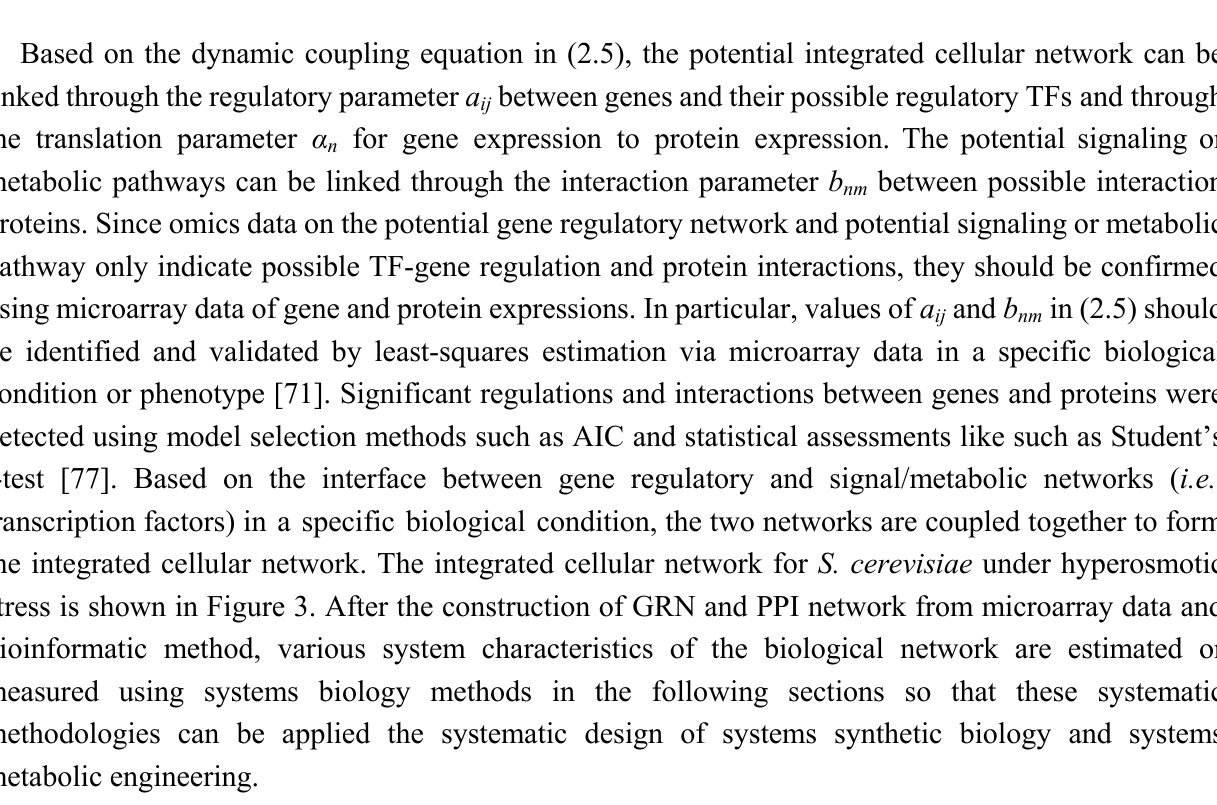
Figure 3. The S. cerevisiae integrated cellular network under hyperosmotic stress.